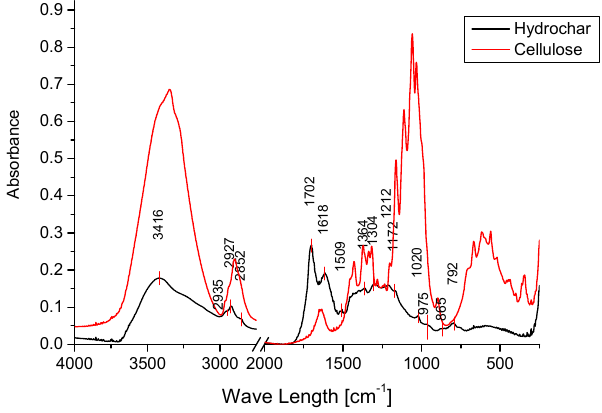
Figure 12. IR spectra of cellulose and its hydrochar (20% DM, 250 °C, and 2 h). (Modified from [21]).